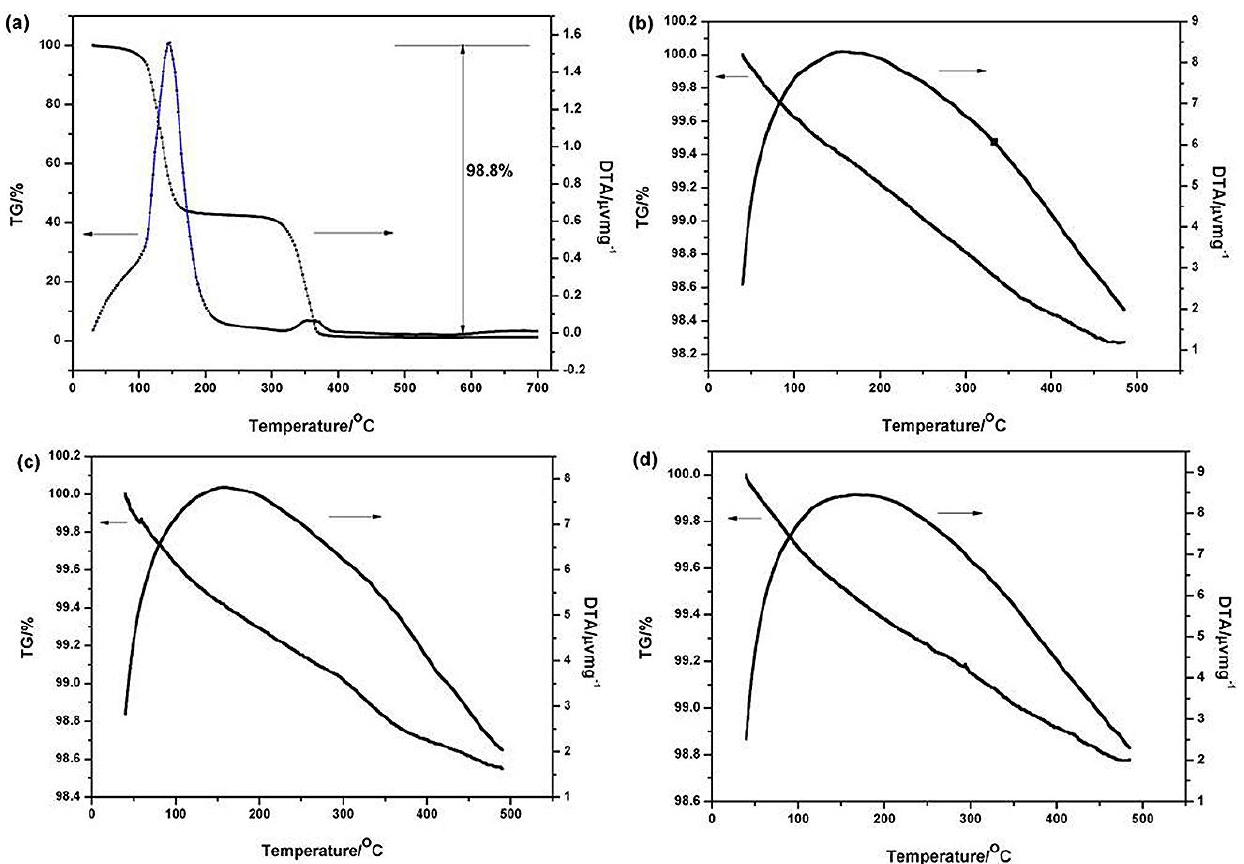
Figure 3. Thermal behavior of ( a ) PEI and ( b – d ) ZSBC-PEI at different pH values: